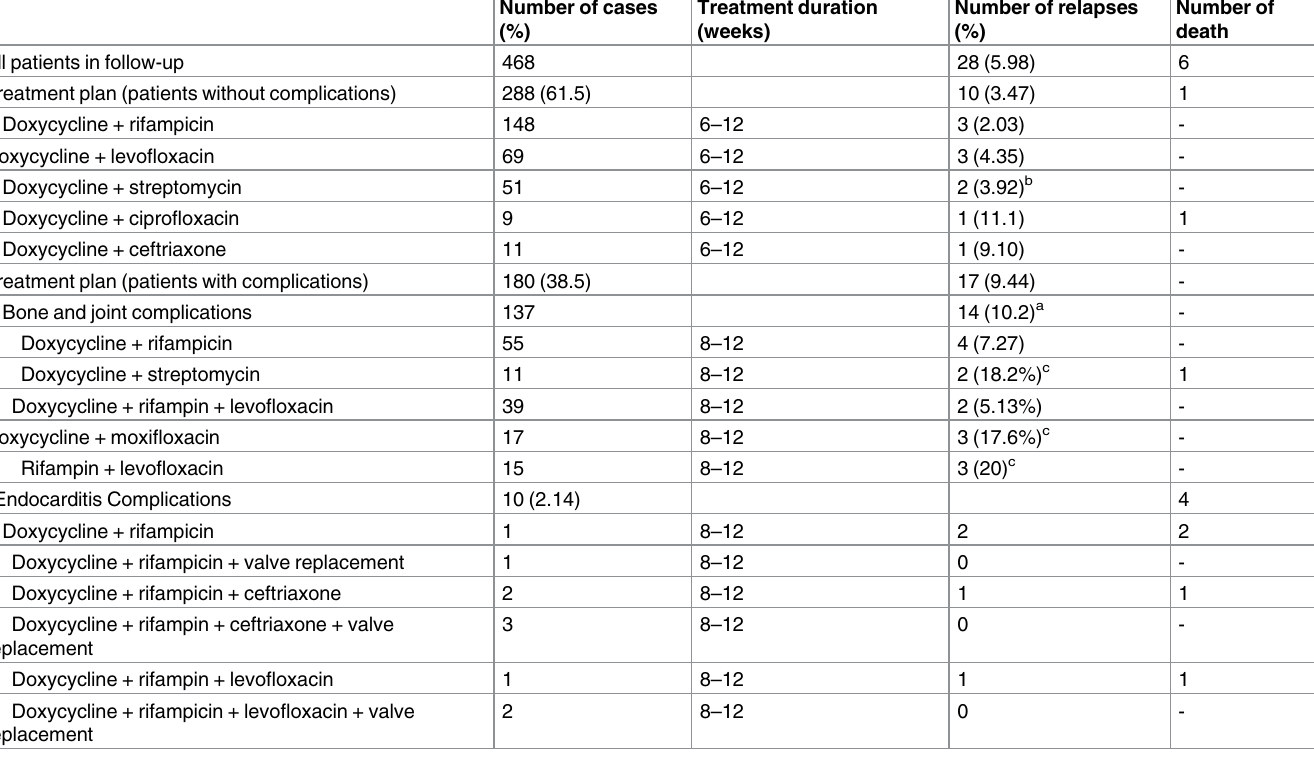
Table 4. Treatment plan, follow-up and